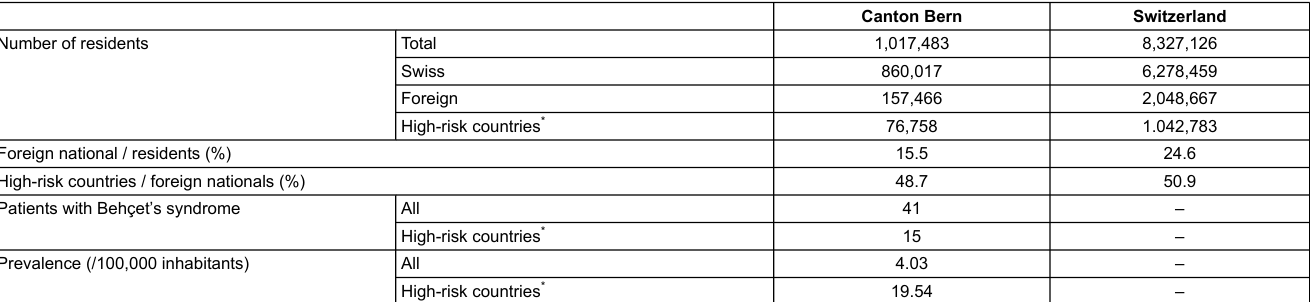
Table 2: Prevalence of Behçet’s